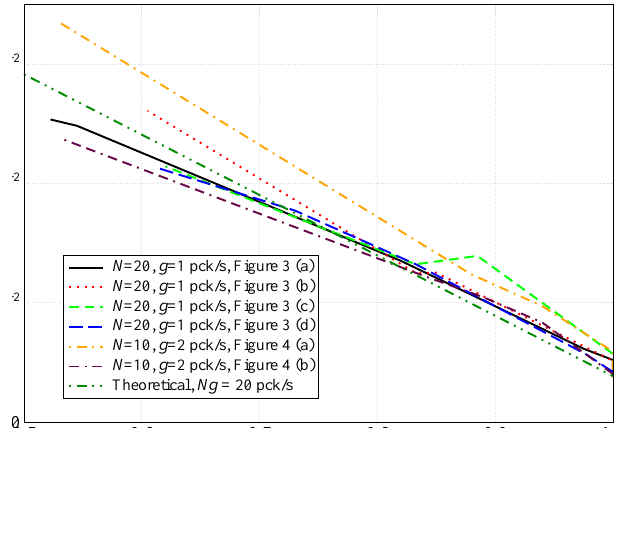
Figure 9. PER as a function of the sparsity index of the adjacency matrix. In the simulations, for scenarios with N = 20 nodes, the packet generation rate is set to g = 1 pck/s, whereas for scenarios with N = 10 nodes, the packet generation rate is set to g = 2